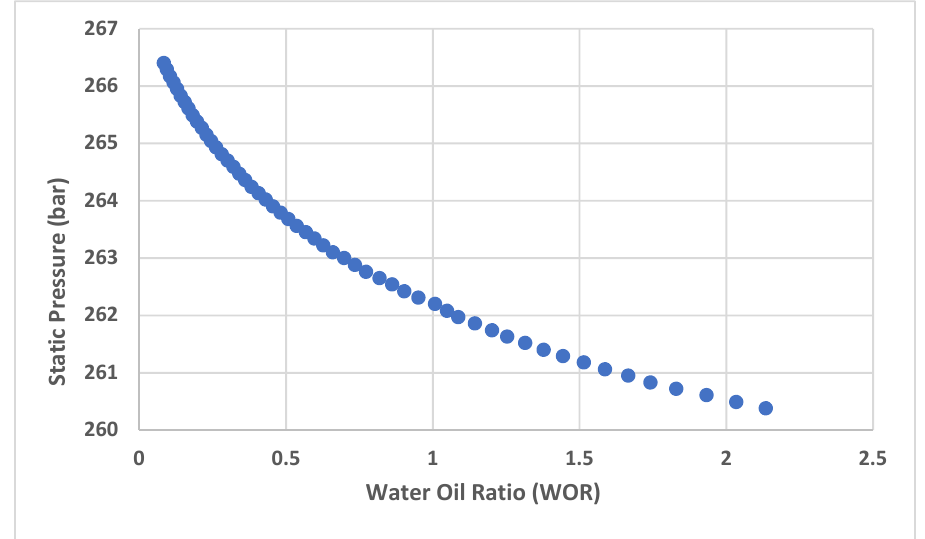
Figure 17. Water–oil ratio (WOR) versus static pressure.